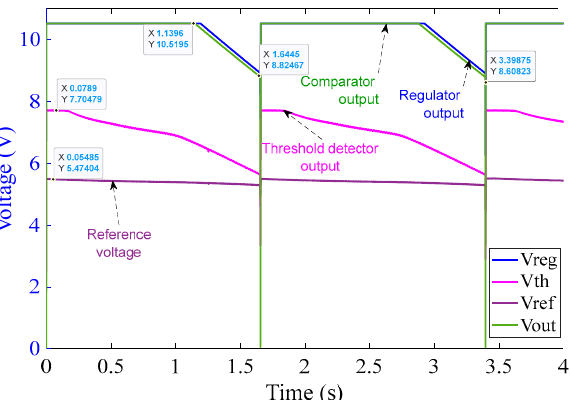
Figure 17. 10 Ω burden circuit operation at 100 A(rms) input current over 4 s (input current not Figure 17. 10 Ω burden circuit operation at 100 A (rms) input current over 4 s (input current not shown for clarity). shown for clarity).